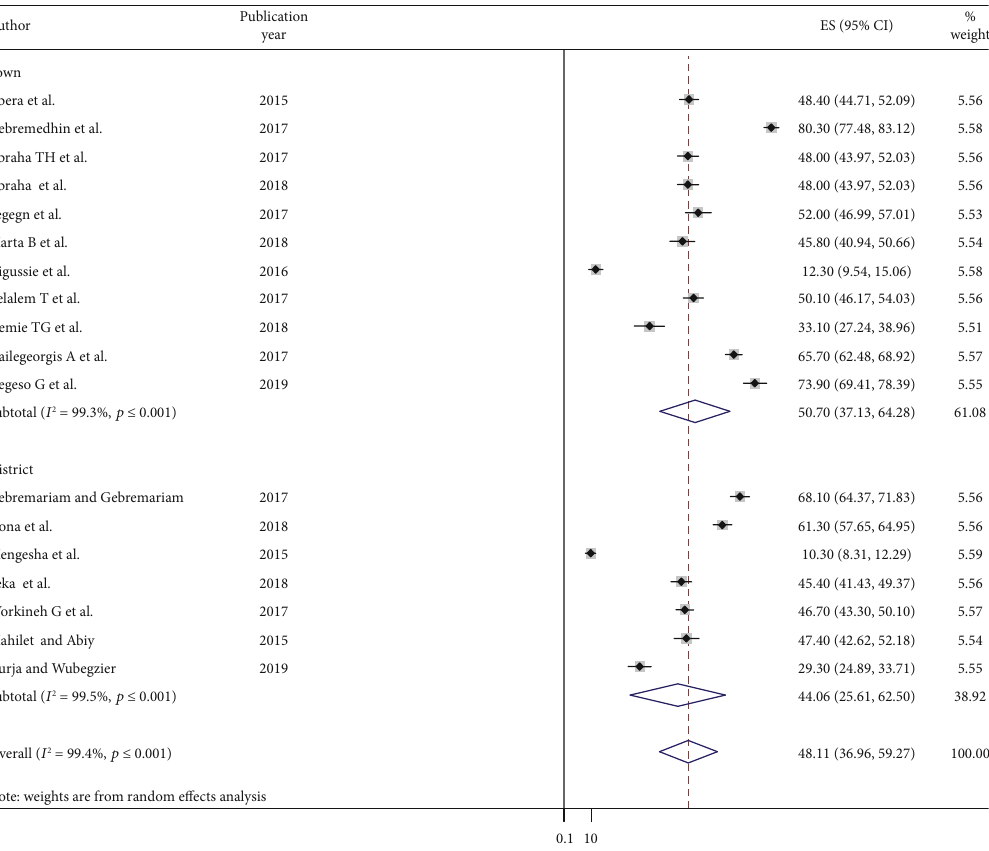
Figure 4: The subgroup analysis of postpartum contraceptive use status by study settings (town and district) in Ethiopia,